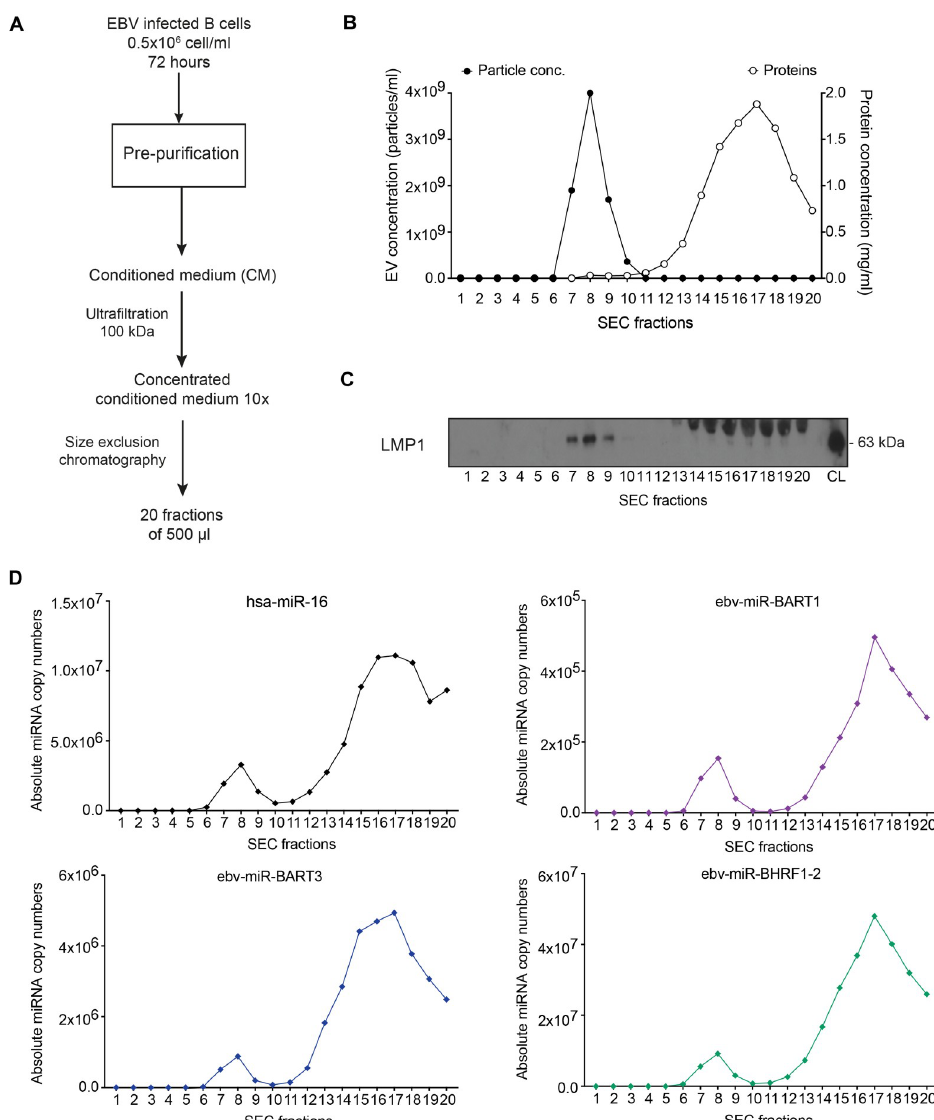
Fig 3. The majority of miRNAs does not co-purify with extracellular vesicles. (A) Schematic overview of the purification of EVs by size-exclusion chromatography (SEC). EBV-infected B cells (LCLs) were seeded at an initial density of 0.5 × 10 6 cells/ml in medium containing 2% of EV-free FCS (see Materials and Methods). After 72 h, the supernatant was harvested and different steps of centrifugation were used to remove cells (300 g for 10 min) and cell debris (2000 g for 20 min), followed by filtration through a 0.45- μ m mesh size filter. The conditioned cell-culture medium was further concentrated 10-fold to a final volume of 1 ml using a 100-kDa centrifugal ultrafiltration device (Amicon). The concentrated conditioned medium was then loaded onto a size-exclusion chromatography qEV column (Izon Science Ltd). 20 fractions of 500 μ l each were collected. (B) Concentration of EV particles and protein was measured in each fraction by NTA and a colorimetric Bradford assay, respectively. (C) EVs were found in fractions 7, 8, and 9 as confirmed by Western blot immunodetection with an LMP1-specific antibody. LCL cell lysate (CL) was used as positive control. The viral LMP1 protein is highly enriched in the membranes of EVs. A non-specific band of about 70 kDa observed in EV-free, protein-enriched fractions 14–20 likely stems from immunoglobulin heavy chain molecules produced by EBV-infected B cells. (D) Using a TaqMan stem loop RT-qPCR, absolute copy numbers of miRNAs were determined in each fraction after size-exclusion chromatography. For each miRNA, a standard regression obtained with a corresponding synthetic miRNA oligonucleotide was used for absolute miRNA quantification. The results show one representative experiment of three.